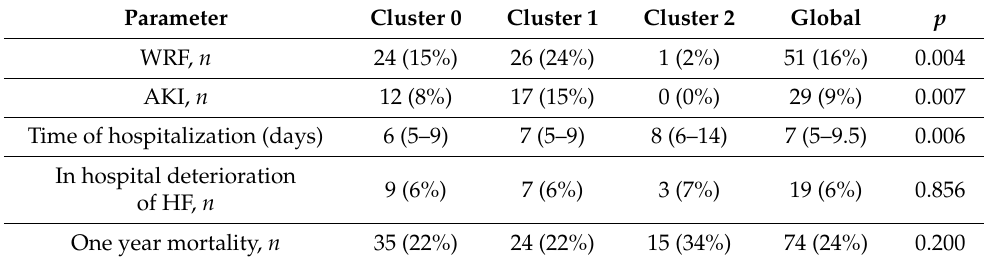
Table 4. Outcome by cluster and in the whole